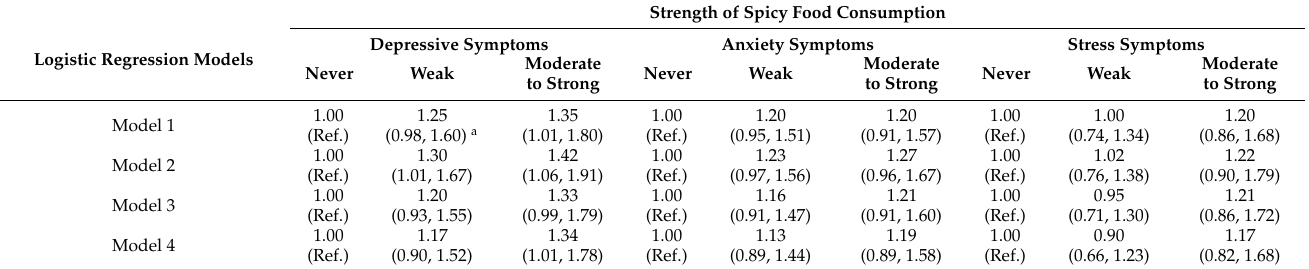
Table 3. Regression coefficients (95% CI) for psychological health by the strength of spice among Chinese college students.